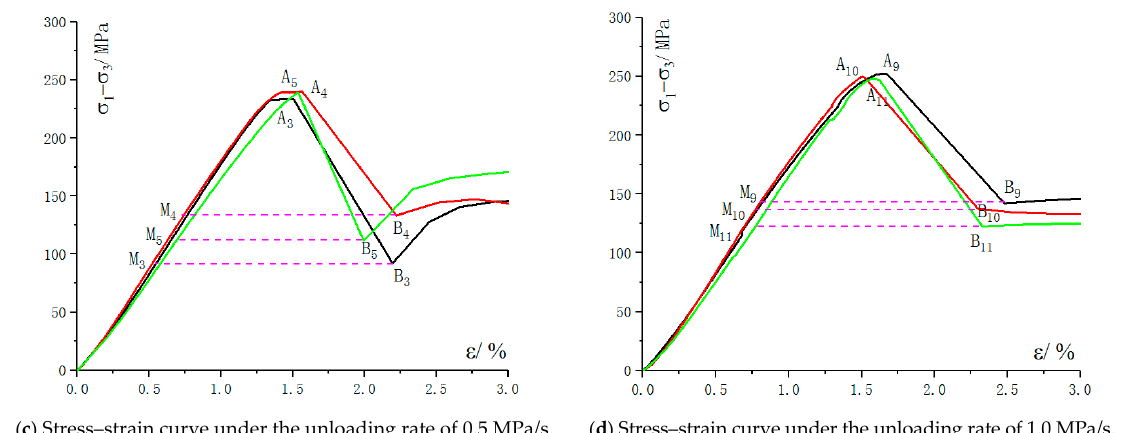
Figure 15. Brittleness stress–strain curve of shale samples under different unloading rates.